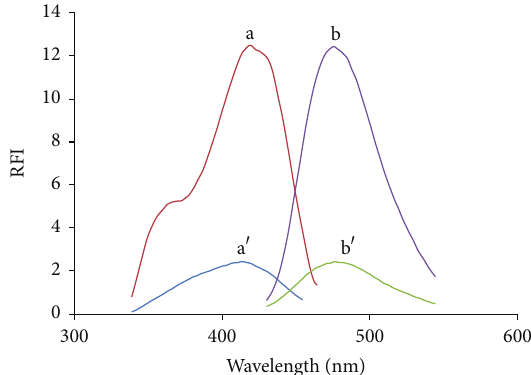
Figure 3: Fluorescence spectra of (a, b) gemifloxacin (1000ng/mL) with acetylacetone-formaldehyde reagent solution, (a 󸀠 , b 󸀠 ) acet- ylacetone-formaldehyde reagent, where (a, a 󸀠 ) are the excitation spectra and (b, b 󸀠 ) are the emission spectra. 𝜆 ex/ 𝜆 em = 420/476